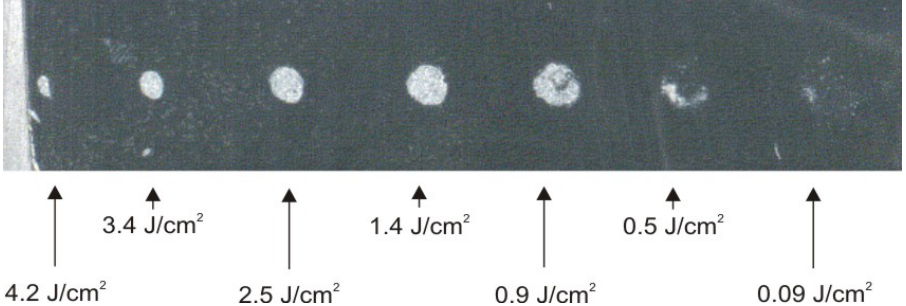
Figure 51. Photographic illustration of influence of different laser fluence on the surface of “Gobro” magmatic rock (Figure